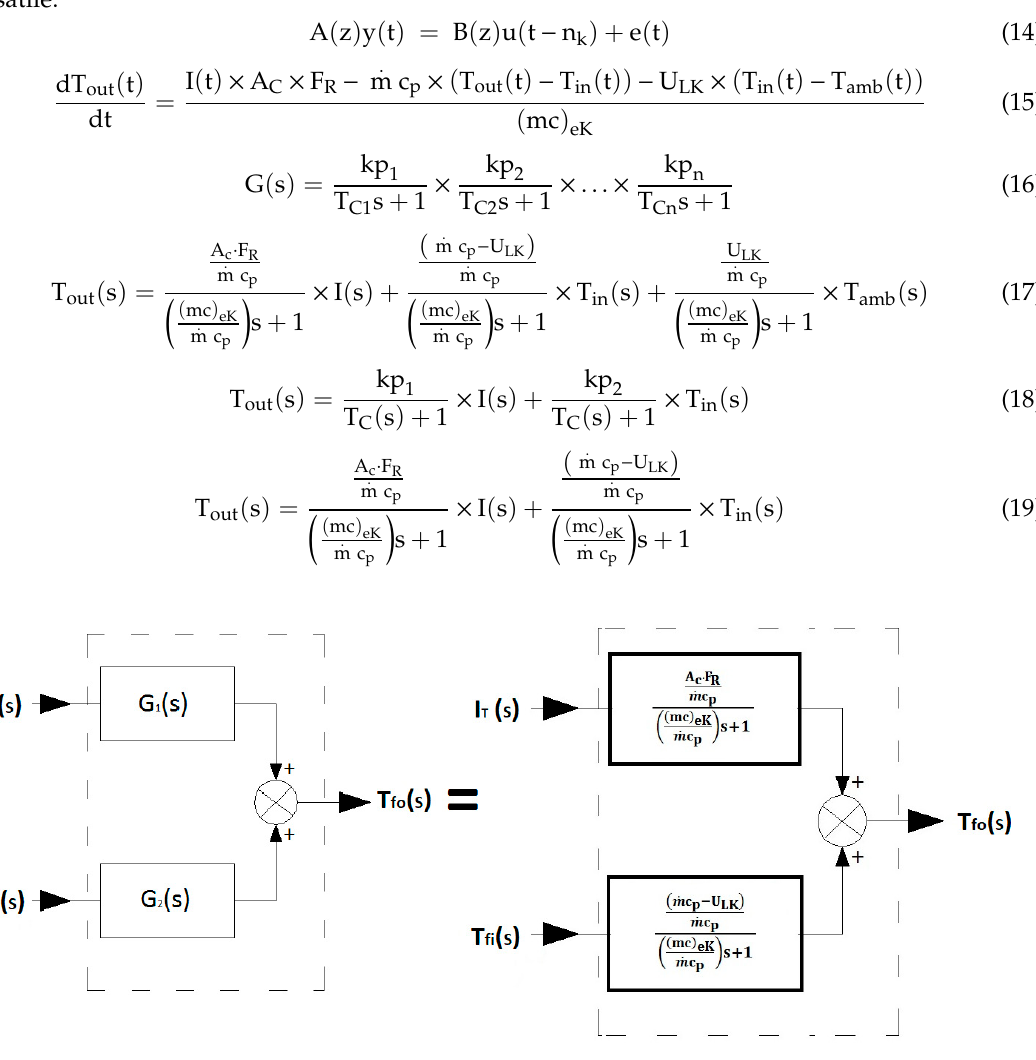
Figure 2. Block diagram of the solar segment model developed based on energy balance for a transient state.